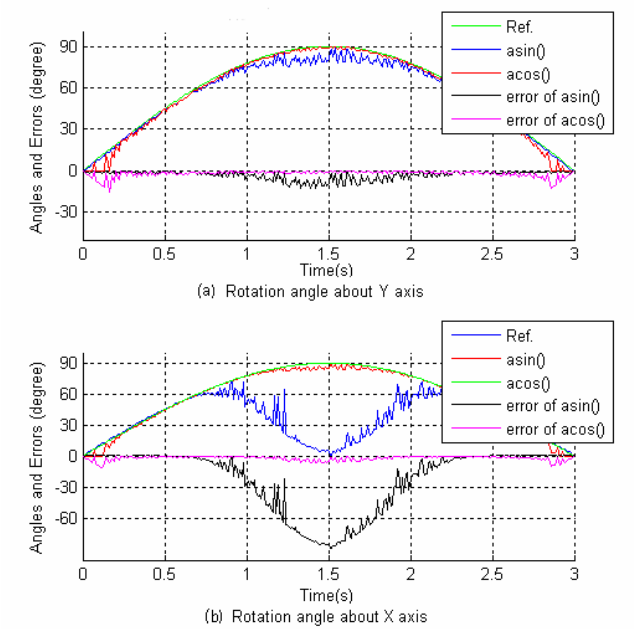
Fig.5 Calculated rotation angles θ y , θ x with noises in half a motion circle (0-90°). Ref means given signal, asin means calculated by arcsine, acos means calculated by arccosine, error by acos means the error when angles are calculated by arccosine, error by asin means the error when angles are calculated by